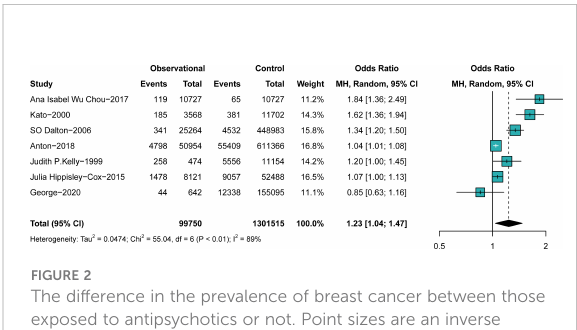
FIGURE 2 The difference in the prevalence of breast cancer between those exposed to antipsychotics or not. Point sizes are an inverse function of the precision of the estimates, and bars correspond to 95% CIs.